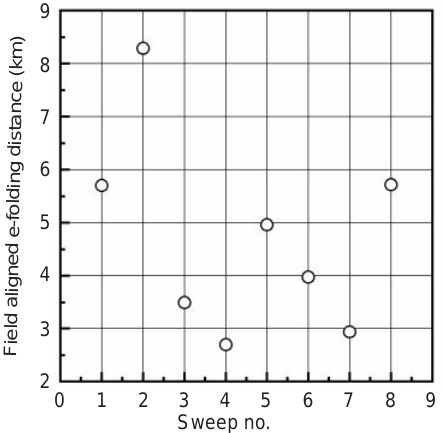
Fig. 4. The e-folding field aligned distances (expressed in kilometres) of the emission growth at the upper frequency cuto(cid:128), estimated for selected sweeps (1 to 8) of the case observed on January